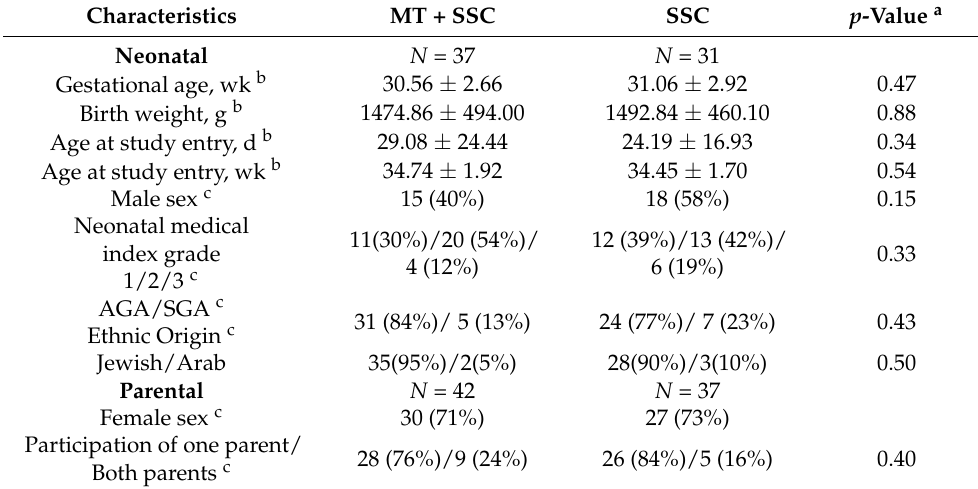
Table 1. Baseline